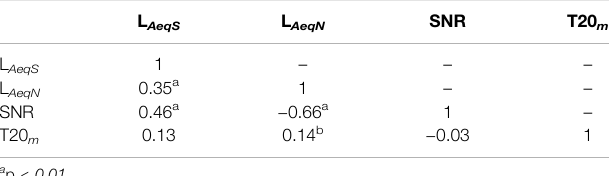
TABLE 3 | Correlations between the input acoustic variables in this investigation: L AeqS , L AeqN , SNR, T20 m .